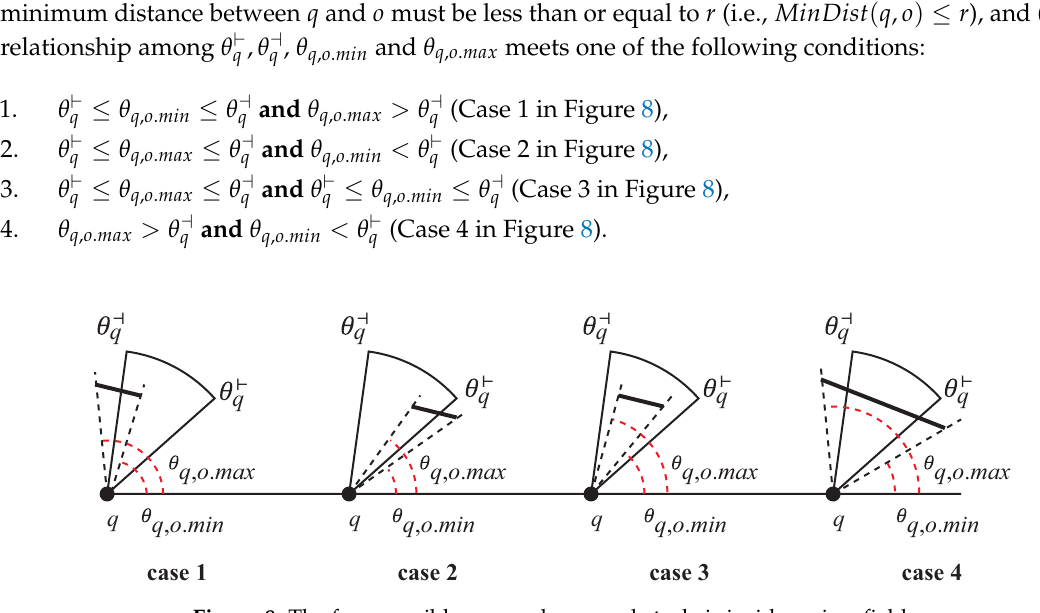
Figure 8. The four possible cases where an obstacle is inside a view field.